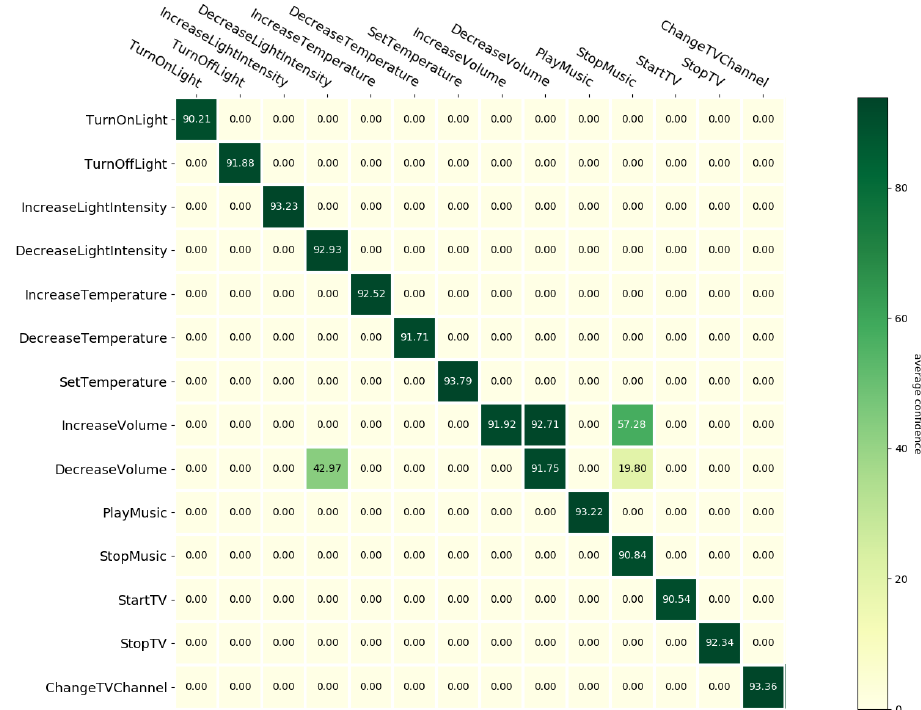
Figure A1. Confidence matrix for Scenario 0.